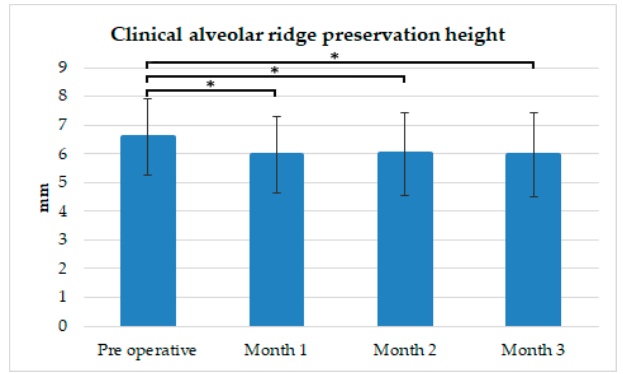
Figure 5. Alveolar ridge height preservation. The composite hydroxyapatite / β -tricalcium (HA / β -TCP) + collagen for alveolar bone height preservation was always slightly more efficacious after the preoperative measurement. * Statistically significant difference between preoperative and postoperative measurements: p < 0.05. Table 4. Variation in alveolar height variation by time of measurement.